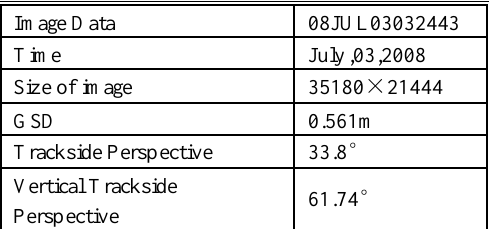
Table 1 Data parameter of test